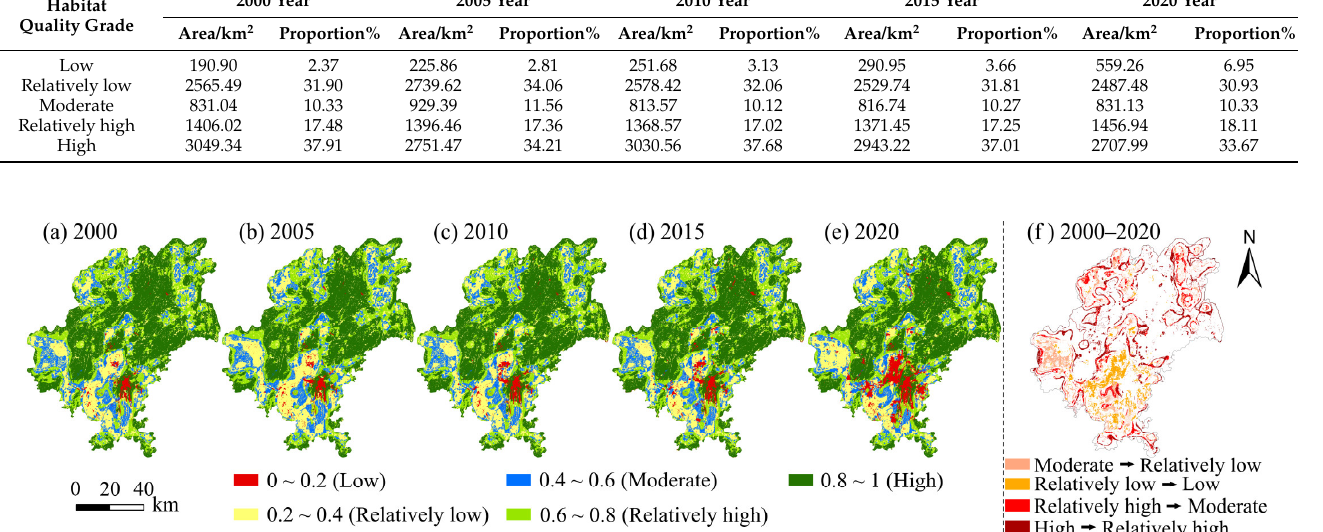
Table 4. Area and change proportion of habitat quality grade in Guiyang from 2000 to 2020.